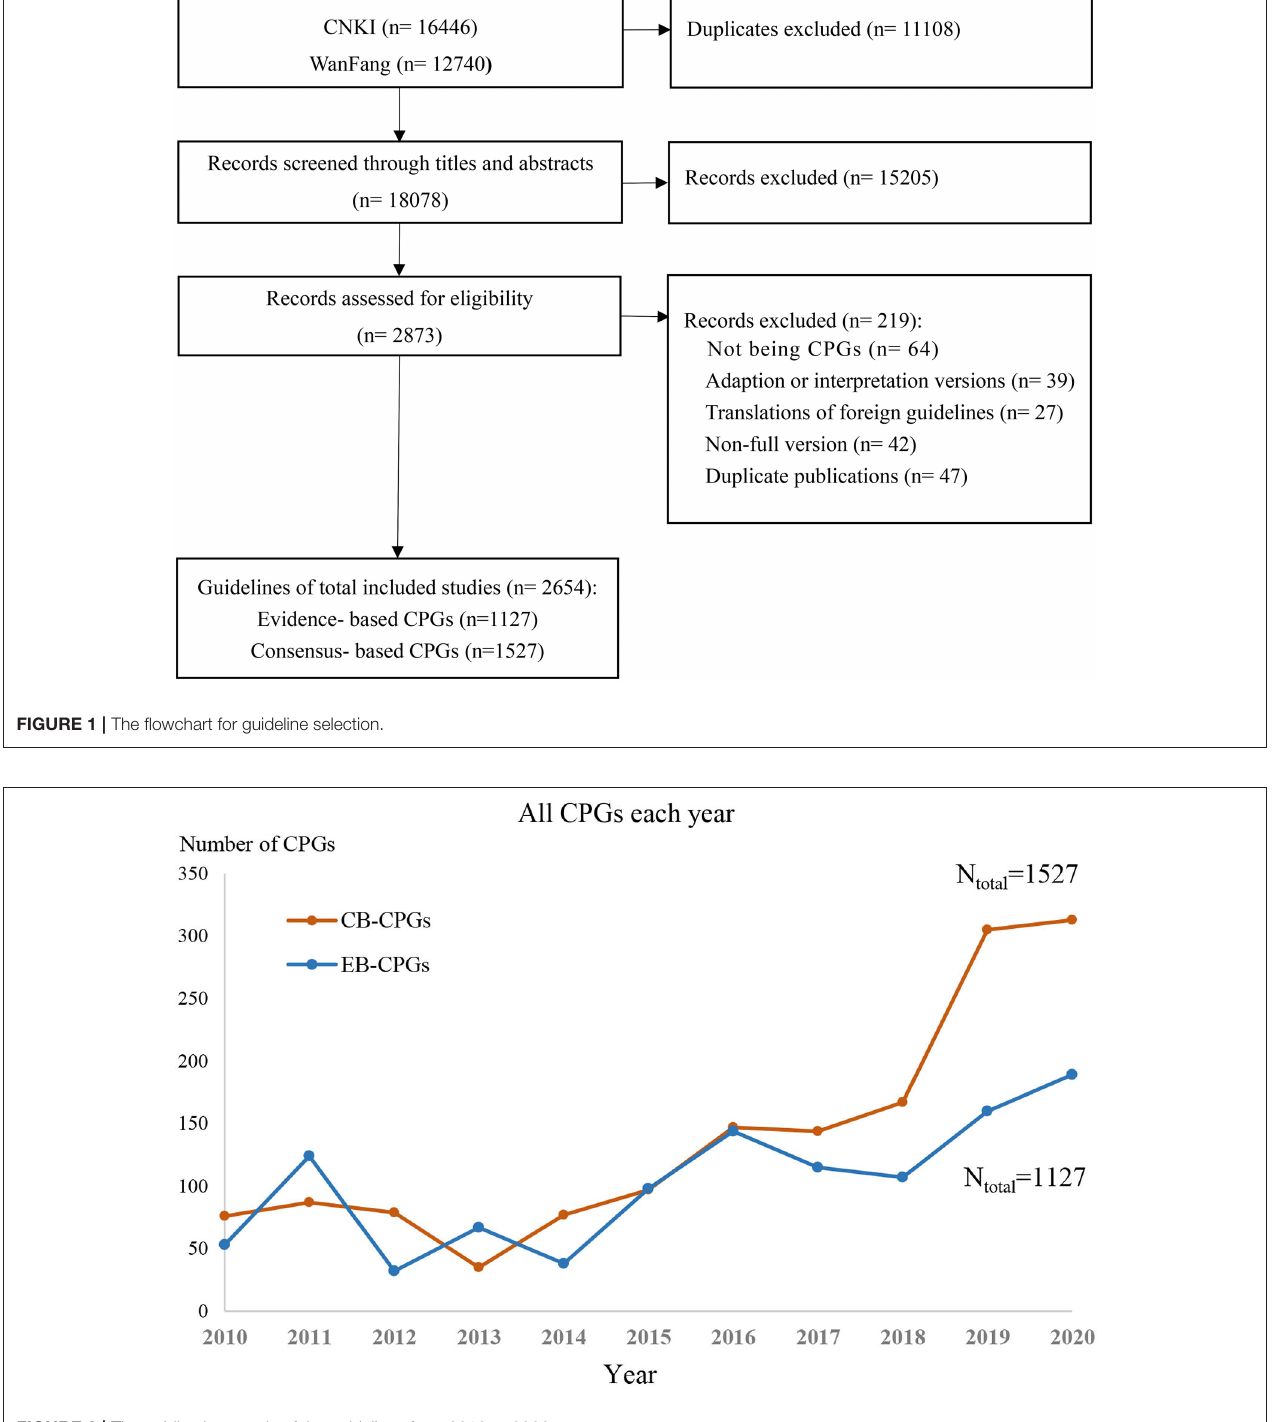
Frontiers in Medicine |